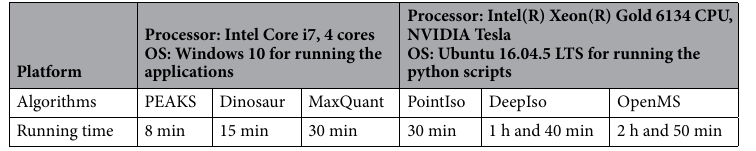
Table 2. Approximated running time of different algorithms. Here the platform used for OpenMS, DeepIso and PointIso did not have support for running Windows application of PEAKS, MaxQuant, and Dinosaur. So we used different machine for running